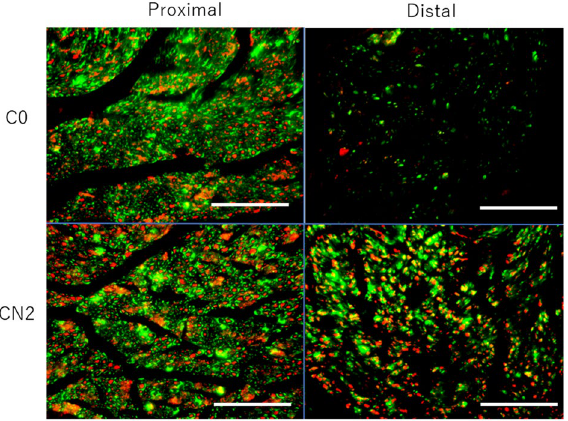
Figure 6. Transvers sections of the proximal and distal nerve segments of the C0 and CN2 groups 16 weeks after implantation. Sections were stained with neurofilament (axons, red), S100 (Schwann cells, green). Scale bar indicates 100 µm.